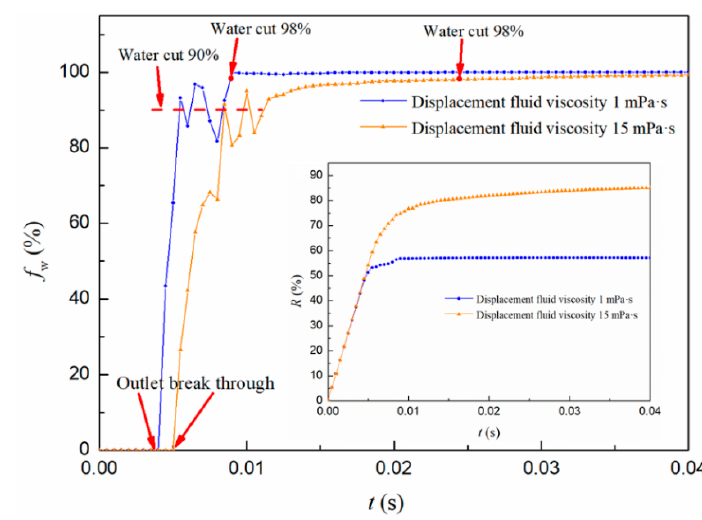
Figure 12. Water cut at the outlet and oil recovery at different displacement fluid viscosities (Y-axis is water cut, % and X-axis is time, s).